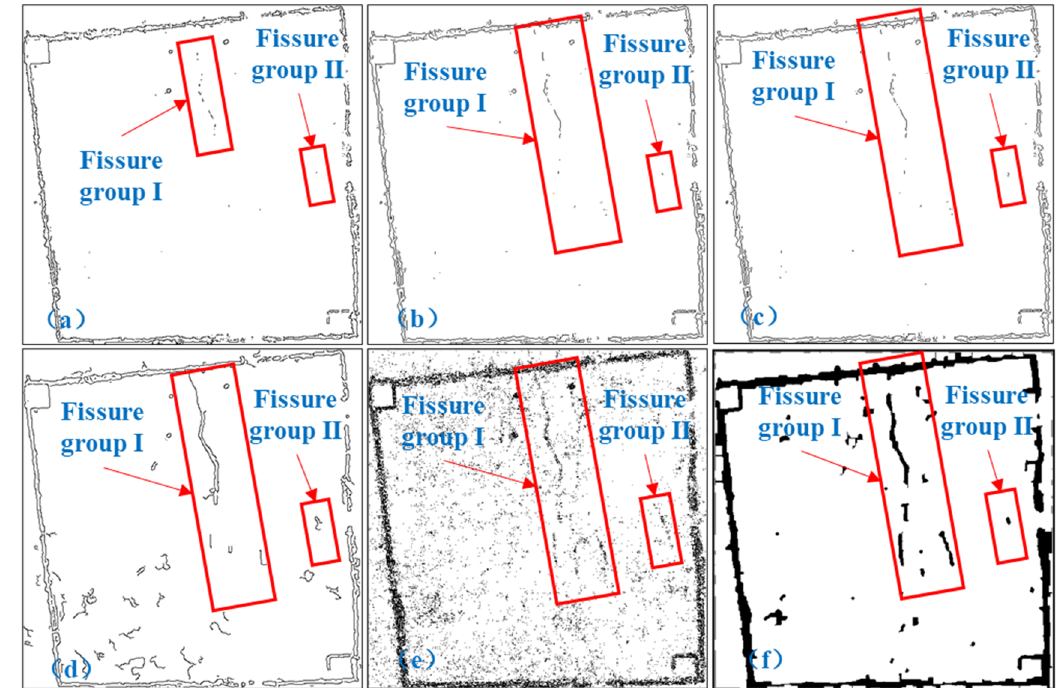
Remote Sens. 2021 , 13 , x FOR PEER REVIEW 13 of 23 Figure 7. Results of mining-induced ground fissure detection using multiple edge detection methods for the visible image. ( a ) Roberts operator. ( b ) Sobel operator. ( c ) Prewitt operator. ( d ) Canny operator. ( e ) Laplacian operator. ( f ) Proposed method.